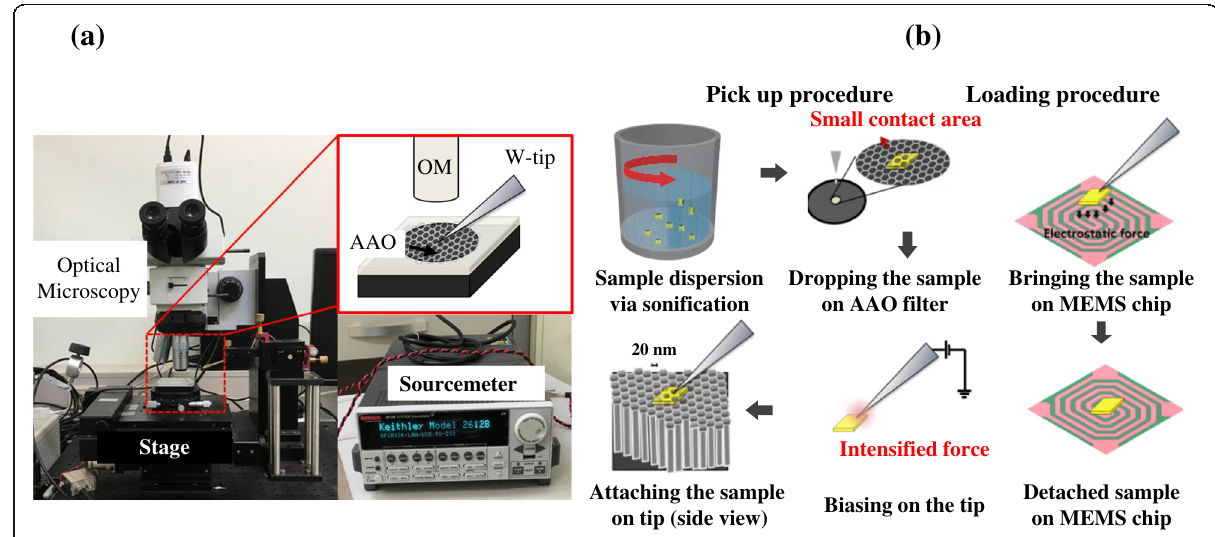
Fig. 1 a Schematic configurations of manipulating system composed of optical microscopy, stage, and sourcemeter. Magnified red-squared region indicates the AAO of 20 nm pores that is put below the sample to reduce the contact area of sample and substrate. b Schematic illustrations of transferring procedure which is divided into pick-up and loading